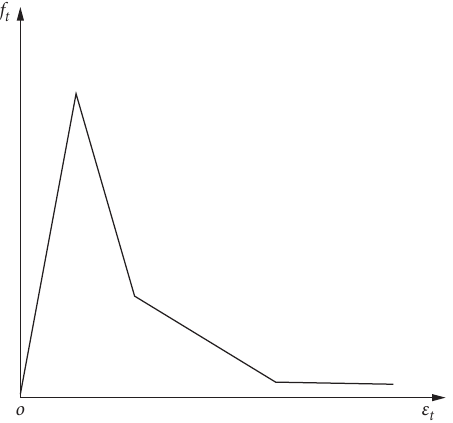
Figure 5: Tensile constitutive relations of a multilinear model.